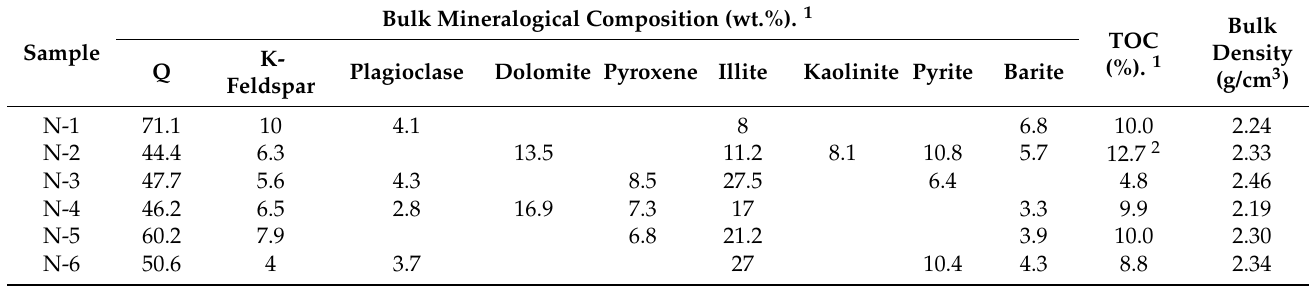
Table 1. Bulk mineralogical, TOC, and bulk density data for the studied sample set [48]. Bulk Mineralogical Composition (wt.%). 1